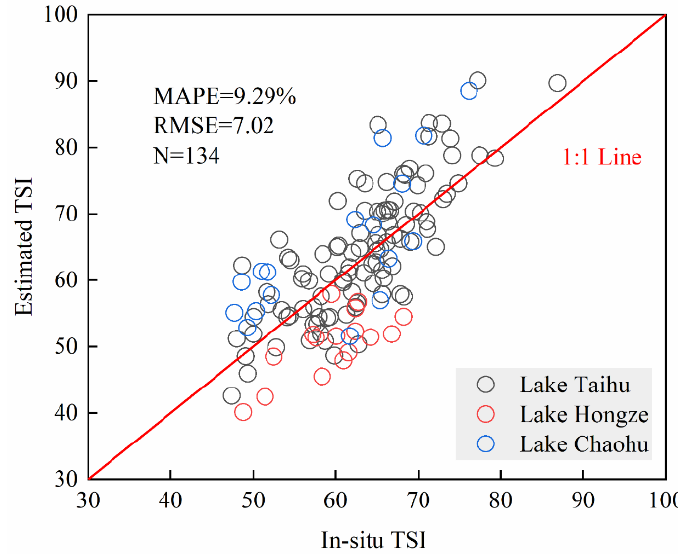
Figure 6. Comparison of in-situ TSI and estimated TSI based on satellite ground synchronous points.